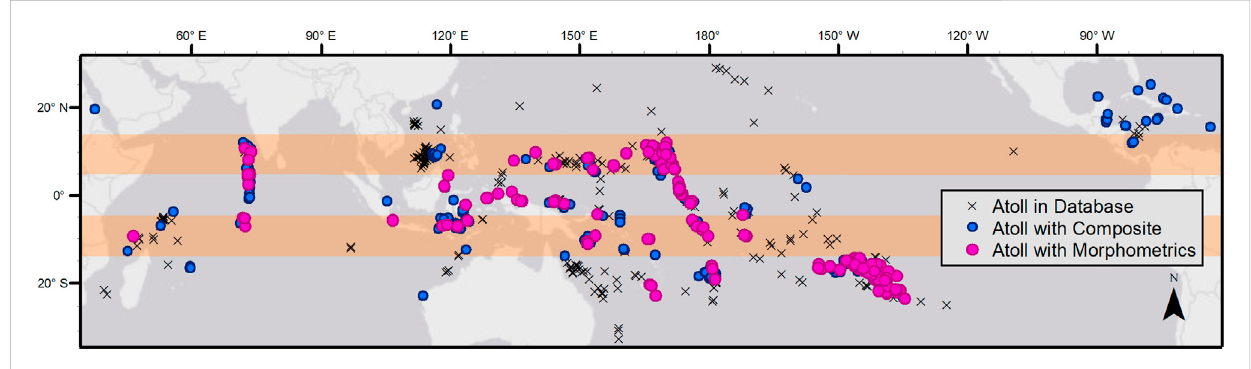
FIGURE 1 Map of atolls worldwide showing locations of atolls in database (black x), atolls with composite imagery created from Landsat (blue dots), and atolls with both composite imagery and morphometrics calculated (pink dots), separated into equatorial (0 ° – 4.7 ° latitude), mid tropical (4.7 ° – 14 ° latitude) highlighted in beige strips, and high tropical (14 ° – 27 °